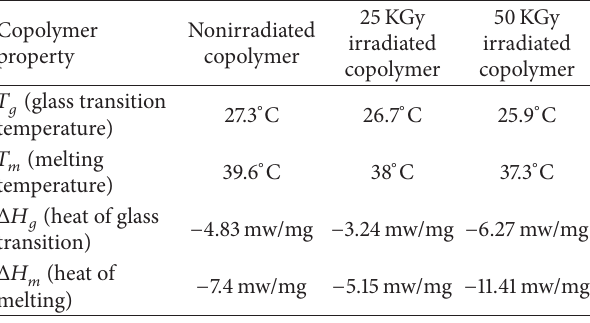
Table 3: Glass transition and melting temperature of irradiated and nonirradiated copolymer samples along with total energy for them.